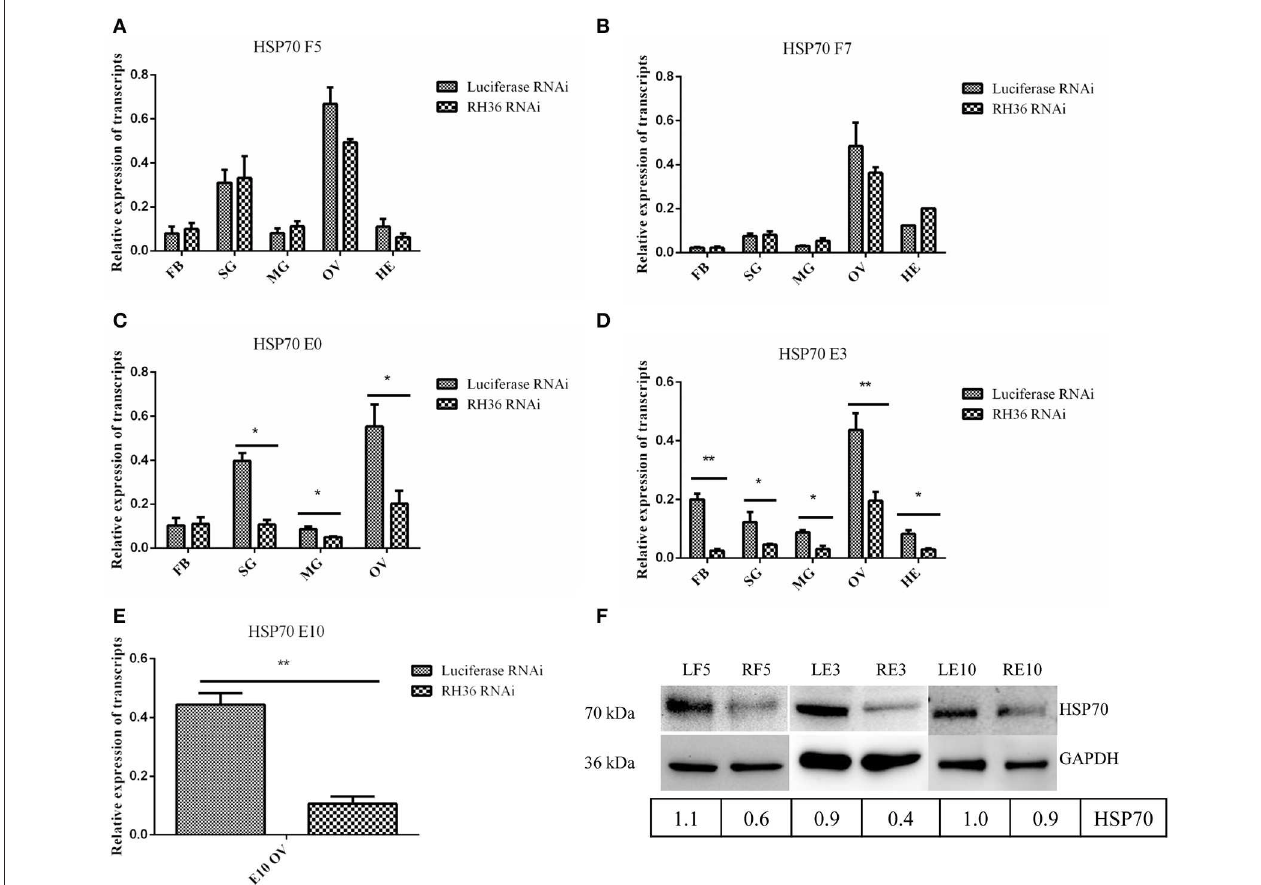
FIGURE 7 | RH36 gene silencing inhibits expression of HSP70 protein after engorgement. Transcript level of HSP70 was detected in the fat body, salivary gland, midgut, ovaries and hemolymph at 5 days blood feeding (A) , 7 days blood feeding (B) , engorgement (C) , 3 days post-engorgement (D) , and 10 days post-engorgement (E) by real-time quantitative PCR, results show HSP70 gene is observably down-regulated in the different organs at engorgement, 3 days post-engorgement and 10 days post-engorgement ( p < 0.05 or p < 0.01). The data were normalized to tick elongation factor 1 α and gene-specific standard was the HSP70 plasmid including open reading frame. ** means highly statistical significance that P-values less than 0.01. * means statistical significance that p -values less than 0.05. Protein level of HSP70 reduced in the ovaries at 5 days blood feeding, 3 days post-engorgement and 10 days post-engorgement by Western blot (F) . The intensities of HSP70 were normalized to GAPDH. GAPDH bands appeared in the previous Figure 4 . GAPDH bands were re-used due to LF5, 5-day-fed ticks from luciferase RNAi groups; RF5, 5-day-fed ticks from RH36 RNAi groups; F7, at day 7 for blood-feeding; E0, on the day of engorgement; LE3, 3 days post-engorgement ticks from luciferase RNAi groups; RE3, 3 days post-engorgement ticks from RH36 RNAi groups; LE10, 10 days post-engorgement ticks from luciferase RNAi groups; RE10, 10 days post-engorgement ticks from RH36 RNAi groups; FB, fat body; HE, hemolymph; OV, ovary; MG, midgut; SG, salivary gland.